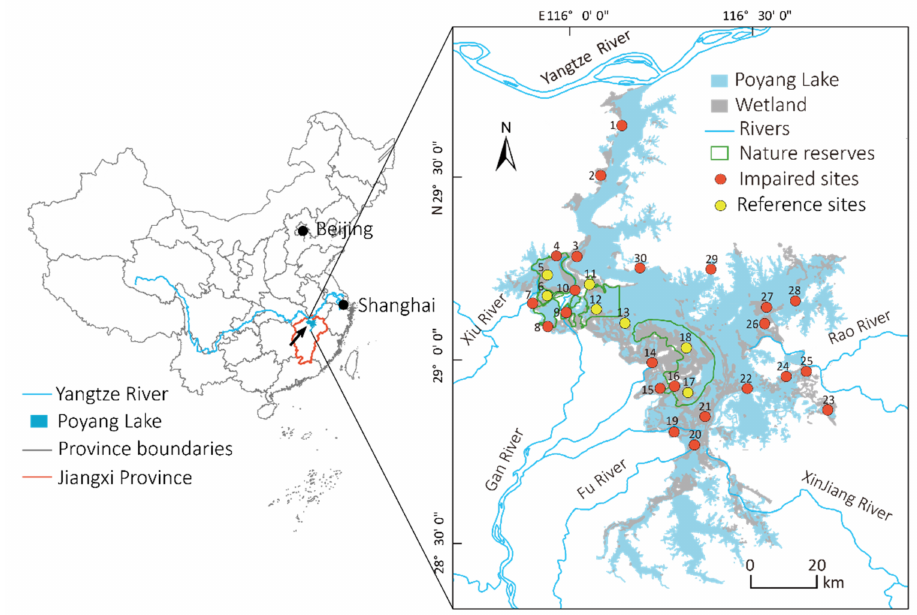
Figure 1. Thirty sites were sampled for collecting environmental and biological data in the Poyang Lake